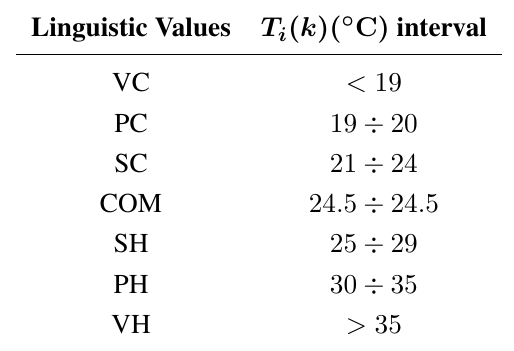
Table 6. Membership function T